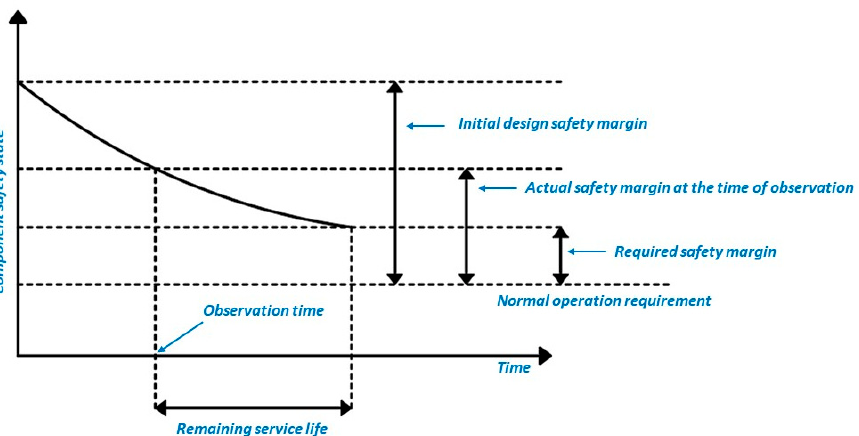
Figure 2. Trend of the safety margin of NPP equipment versus lifetime. Large safety margin would counter the ageing expected degradation [15].